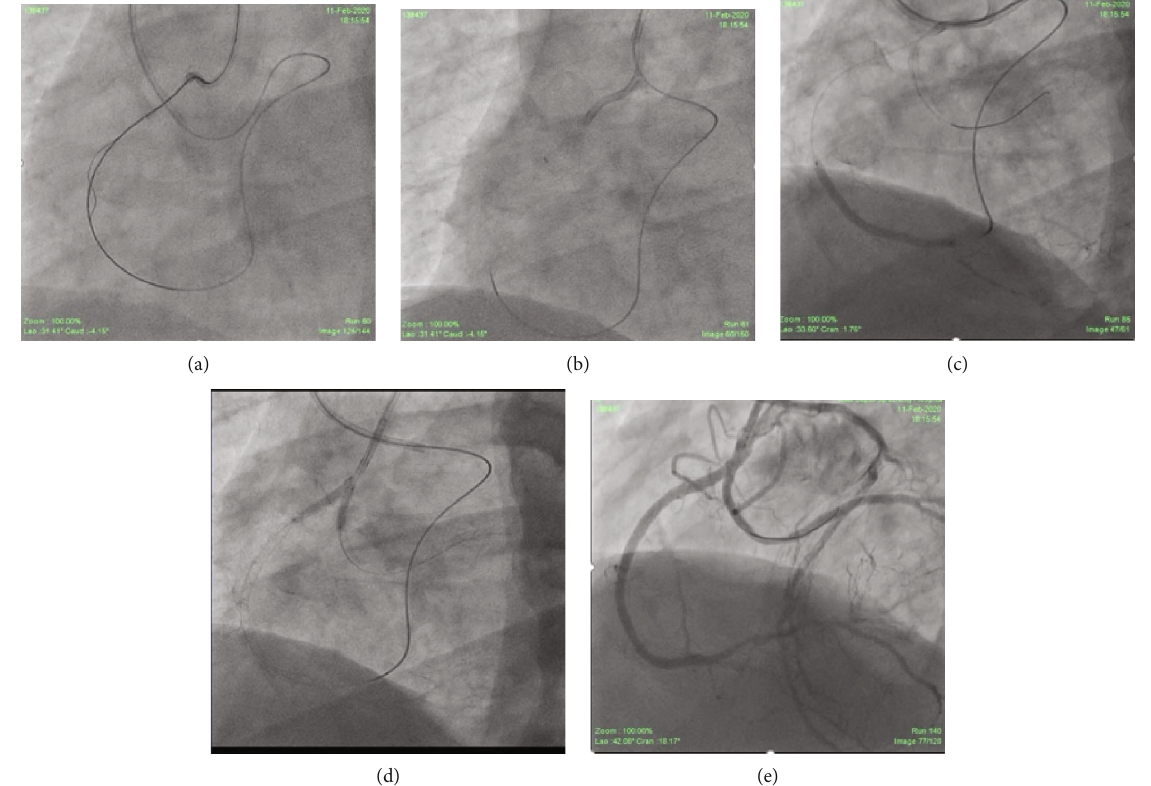
Figure 2: (a) RG3 wire externalized with the help of guideliner. (b) Corsair taken back. (c) 3 stents deployed sequentially. (d).Final proximal kissing. (e) Final